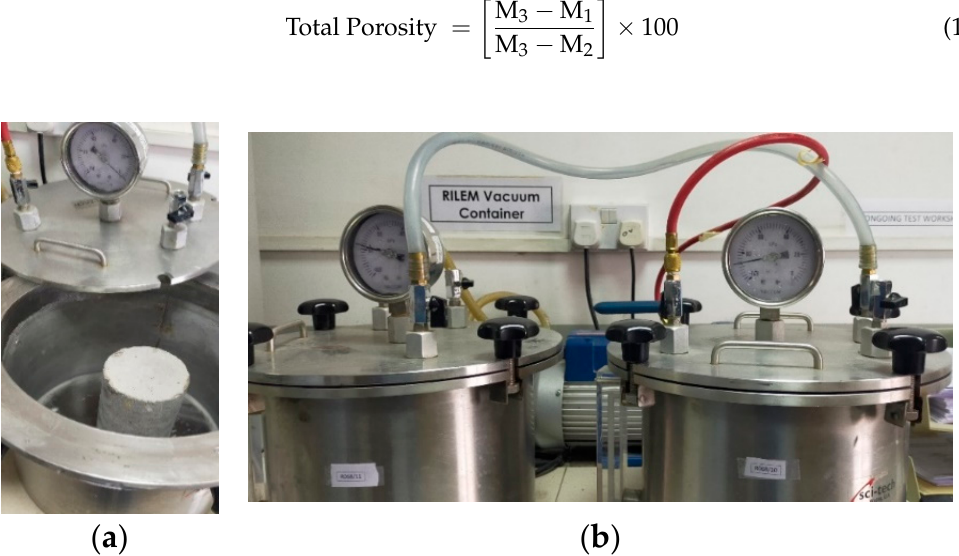
Figure 2. Vacuum conditioning with and without water as part of RILEM CPC 11.3: ( a ) concrete specimen in a vacuum container prior to start of test; and ( b ) vacuum conditioning of a concrete specimen.